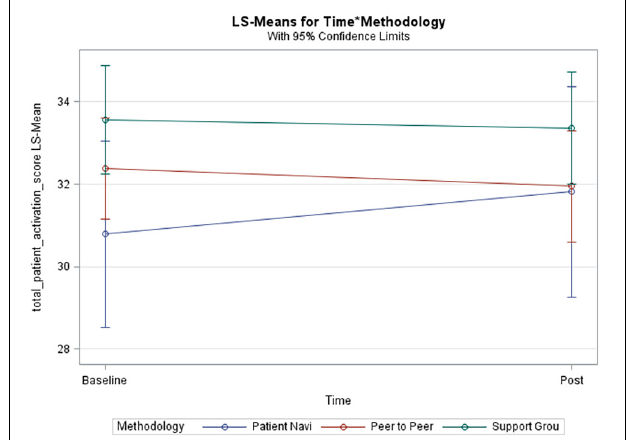
FIGURE 1 | Unadjusted model of total patient activation score. Blue line (Patient Navi), patient navigator methodology; Red line (Peer to Peer), peer-to-peer methodology; Green line (Support Grou), support group methodology.